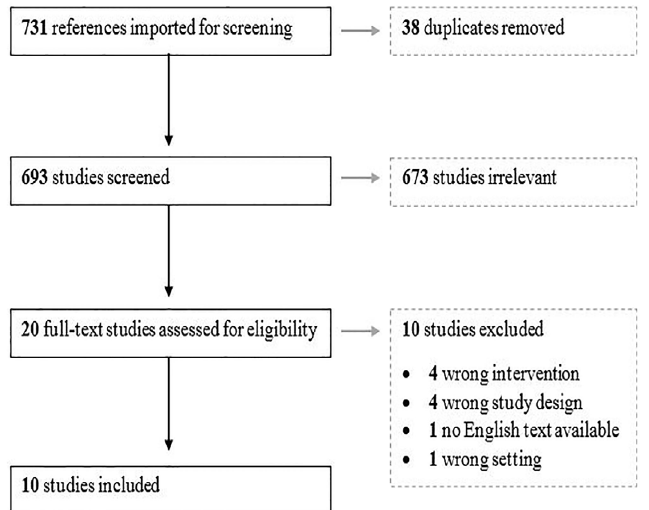
Figure. PRIMSA flow